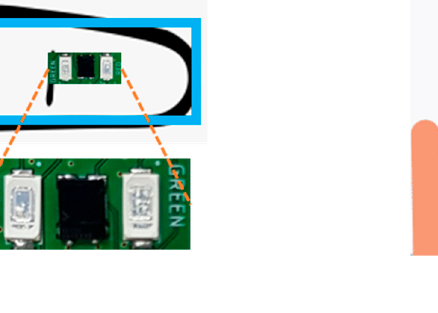
Figure 20. ( a ) Finger location to randomly attach the sensor to acquire PPG signals with and without motion for evaluation purposes, and ( b ) affirmed finger ‐ sensor attachment in finger probe.